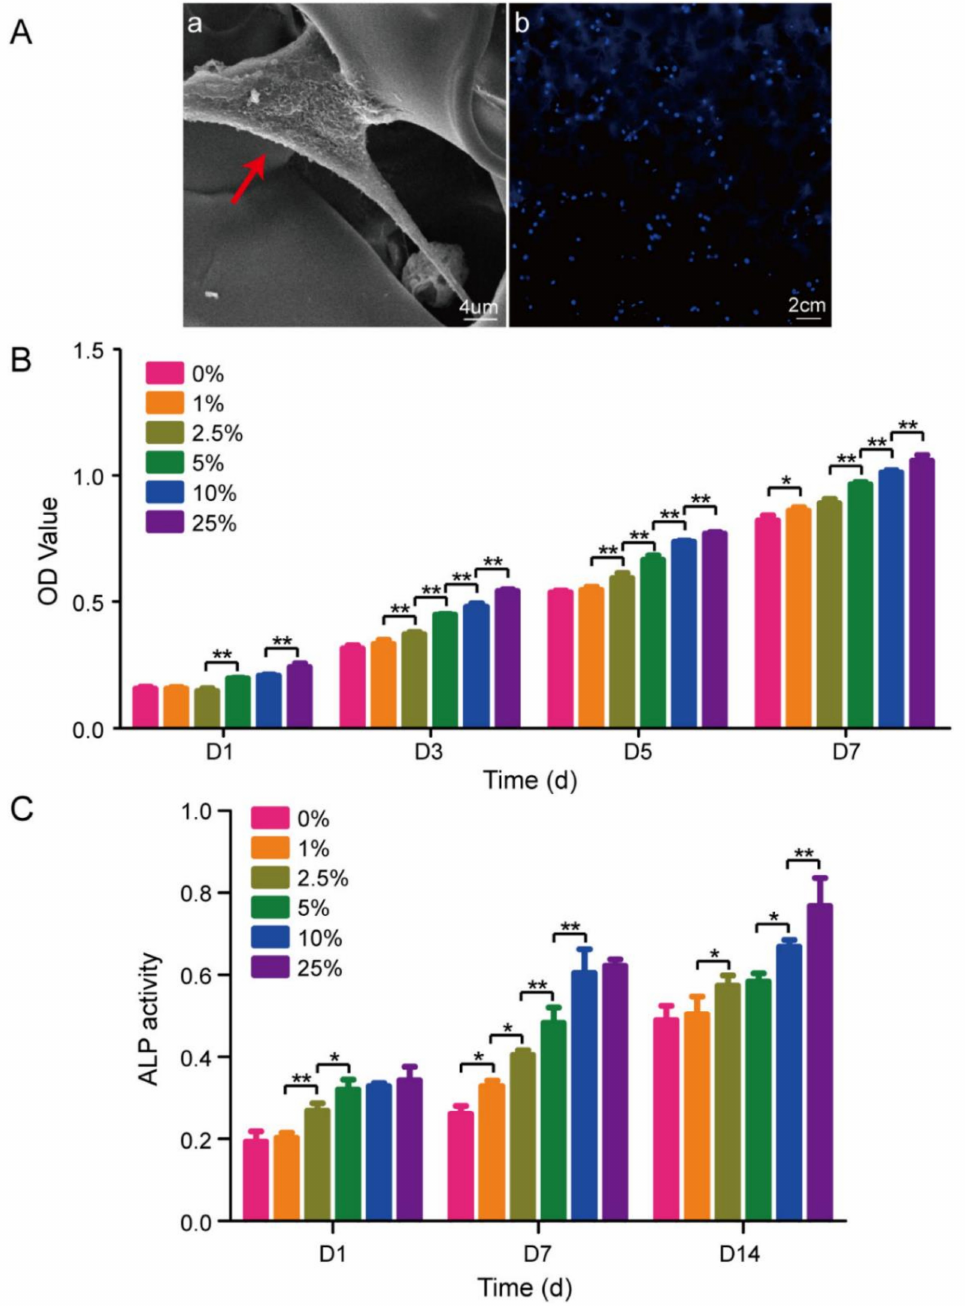
Figure 4. ( A ) SEM images: (a) cell morphology and (b) distribution of cells cultured on C-HLA/NPP scaffold after 4 weeks; ( B ) cell proliferation on scaffolds at day 1, 3, 5, and 7; ( C ) ALP activity of cells on day 1, 7, and 14. Reproduced from [70]. * p < 0.05, and ** p <